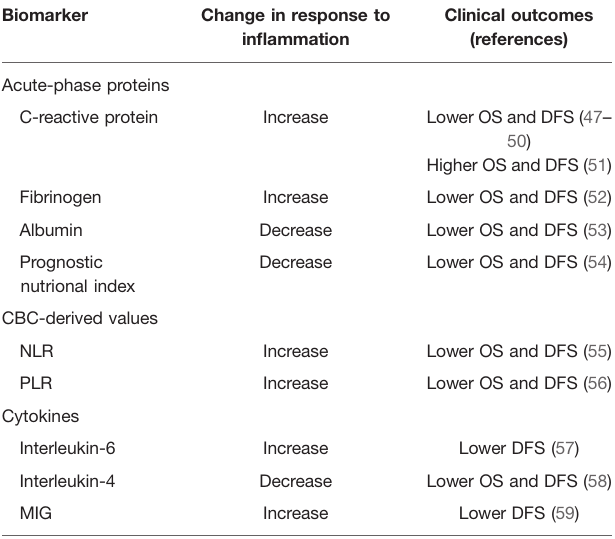
TABLE 1 | Common in fl ammatory biomarkers as prognostic parameters after lung cancer surgery.